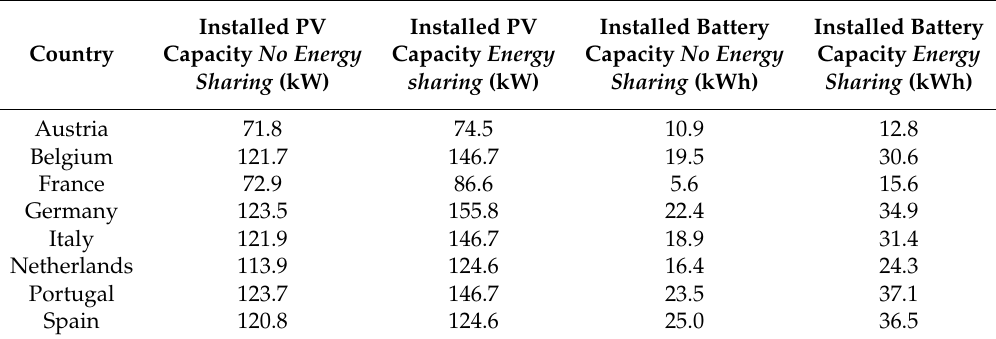
Table 1. Results of economic optimization, from